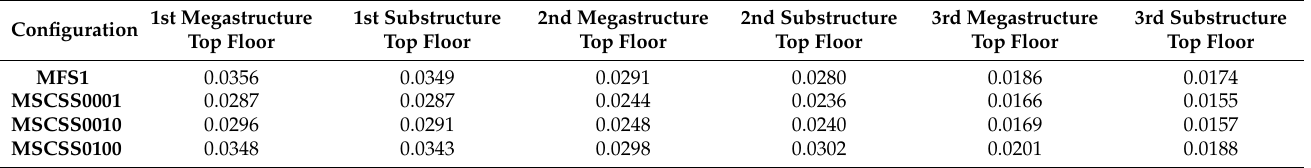
Table 6. The velocity response at a critical point of the investigated configurations under the TAFT wave (m s − 1 ).